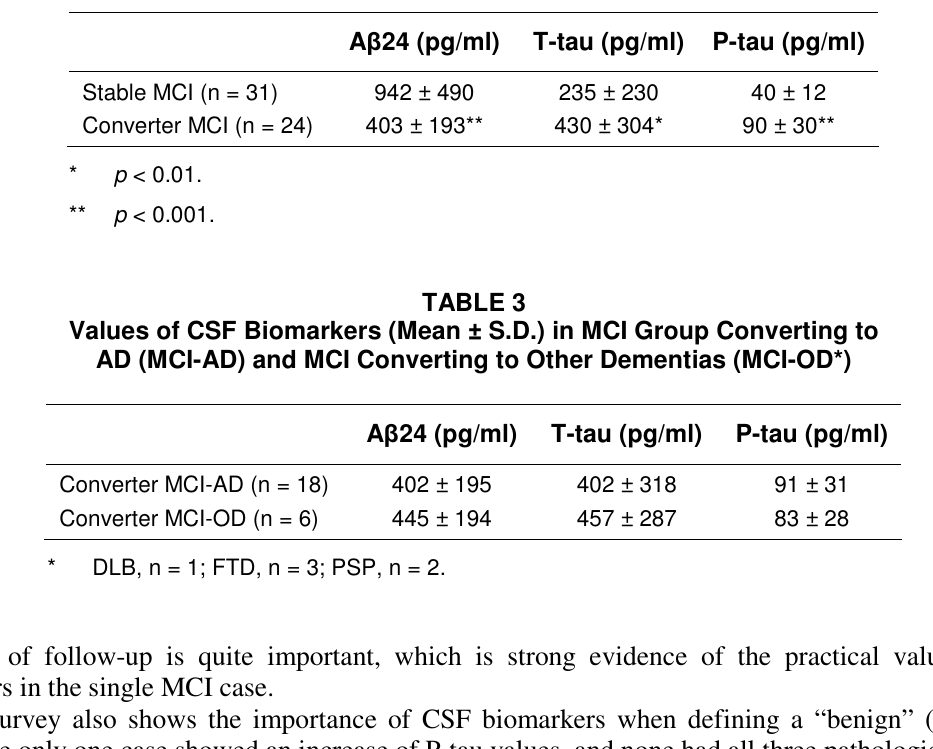
Values of CSF Biomarkers (Mean ± S.D.) in Stable and Converter MCI Subgroups